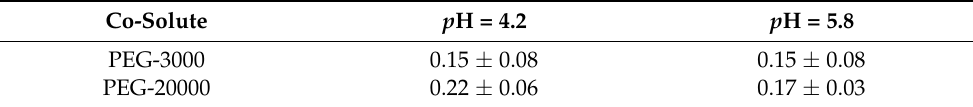
Table 1. Stern-Volmer quenching constants ( K SV ) in L mol − 1 for BSA in the presence of PEG-3000 and PEG-20000 at p H = 4.2 and p H = 5.8 ( T = 25